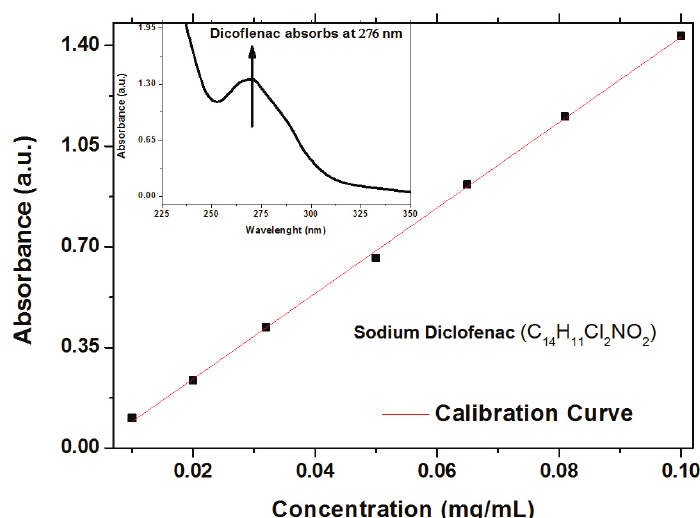
Figure 2. Absorbance instensity as a function of sodium diclofenac concentration in solution. Notice that the insert graph shows a typical spectrum of sodium diclofenac.